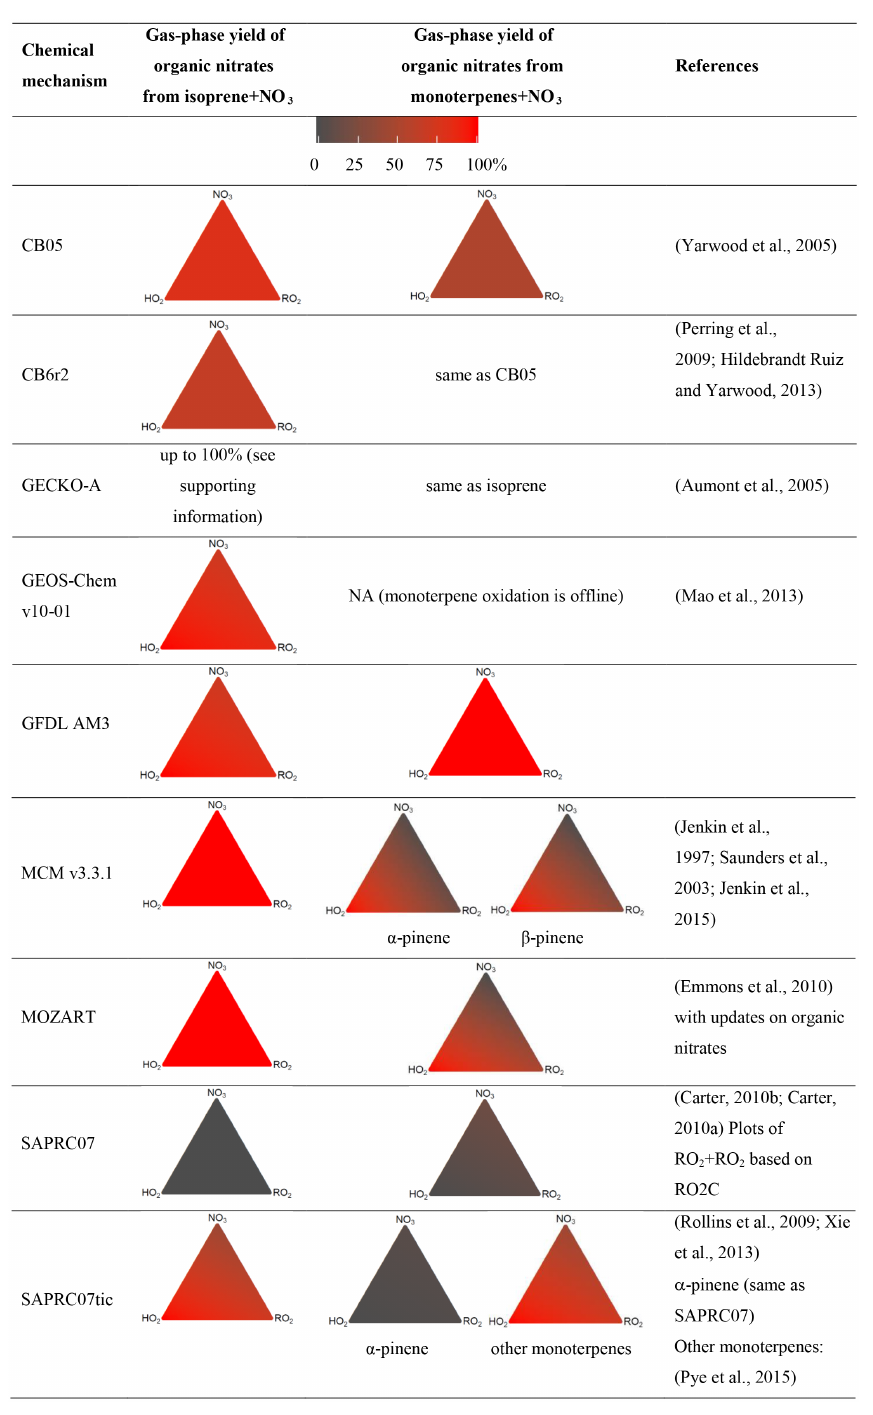
Table 4. Gas-phase organic nitrate yields (in percent) from BVOC + NO 3 systems in current chemical mechanisms. Gas-phase